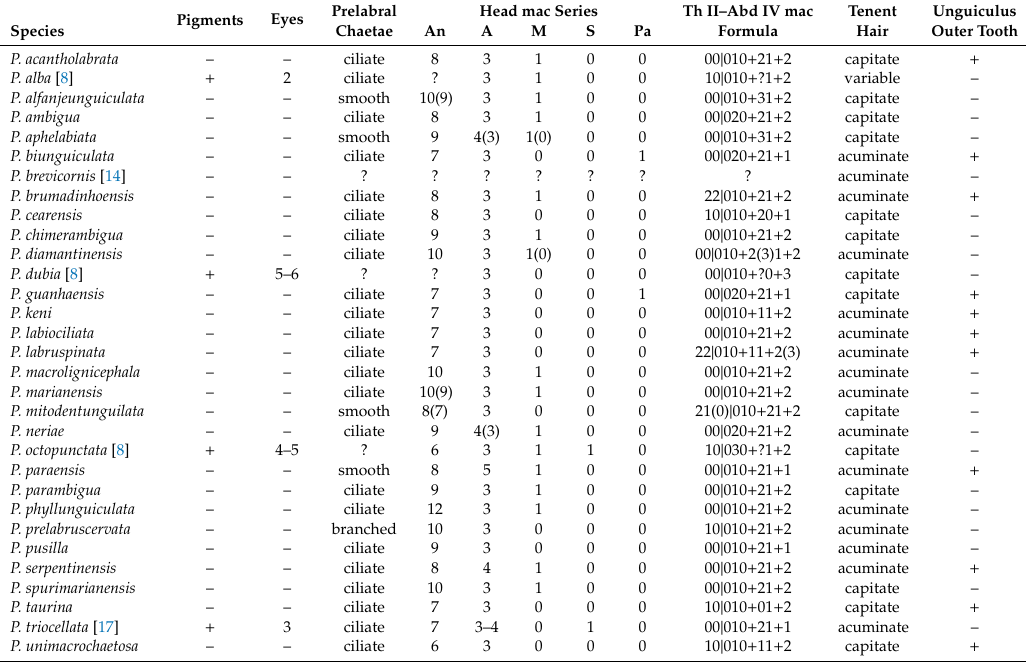
Table 1. Comparison (per side) among 31 species of Pseudosinella recorded from